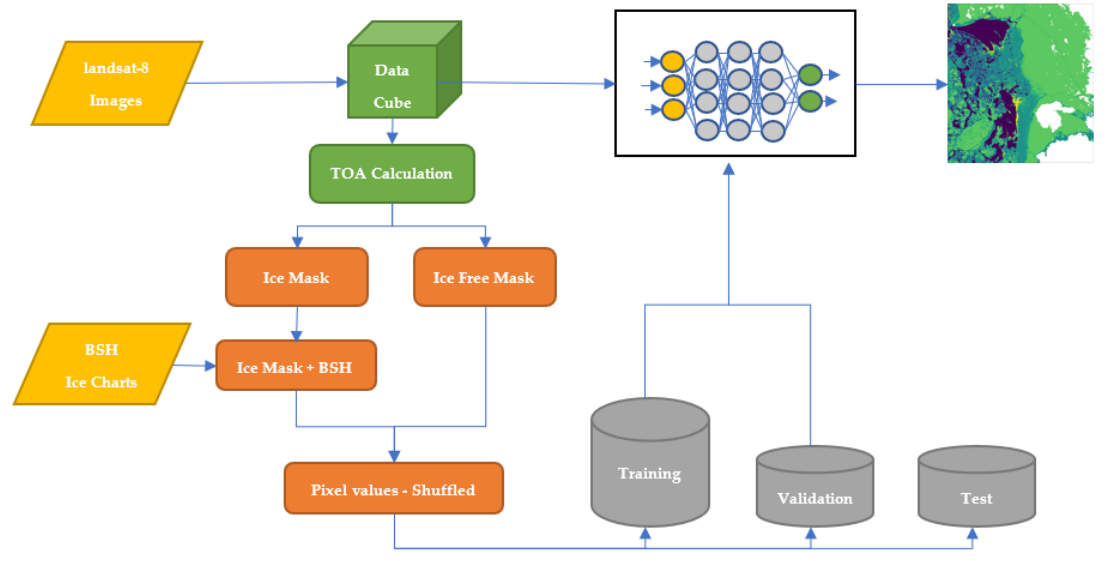
Figure 2. Ice classification general flowchart.